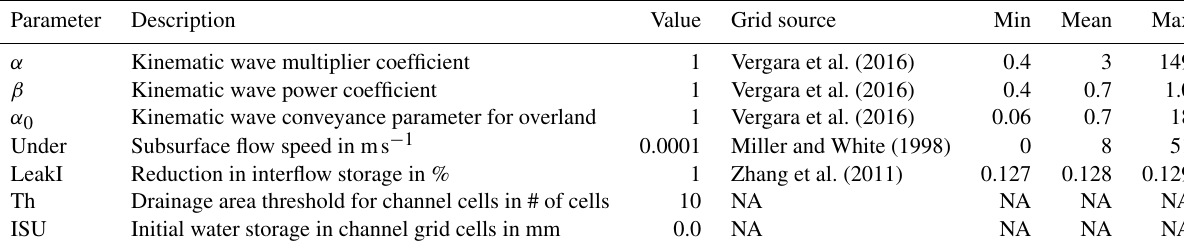
Table 4. Description of parameters used in kinematic wave routing scheme.